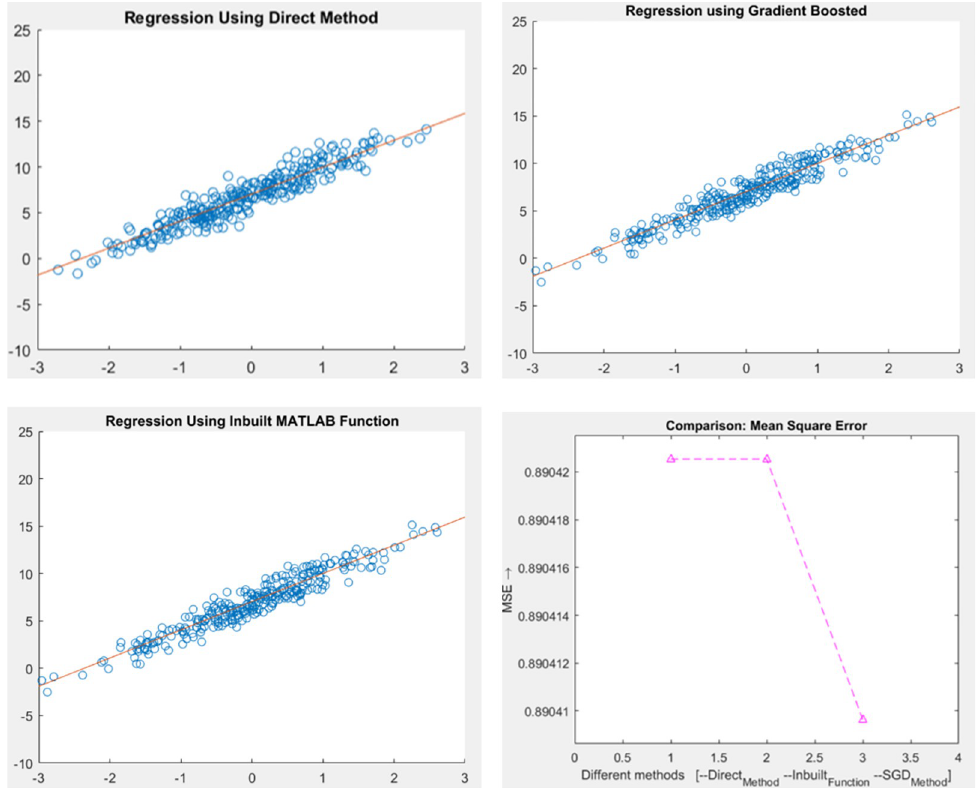
Fig 7. (a). Proposed result using direct method. (b). Proposed result using gradient boost regression. (c). Proposed result of hybrid method using In–Built MATLAB. (d). Proposed result of mean square error